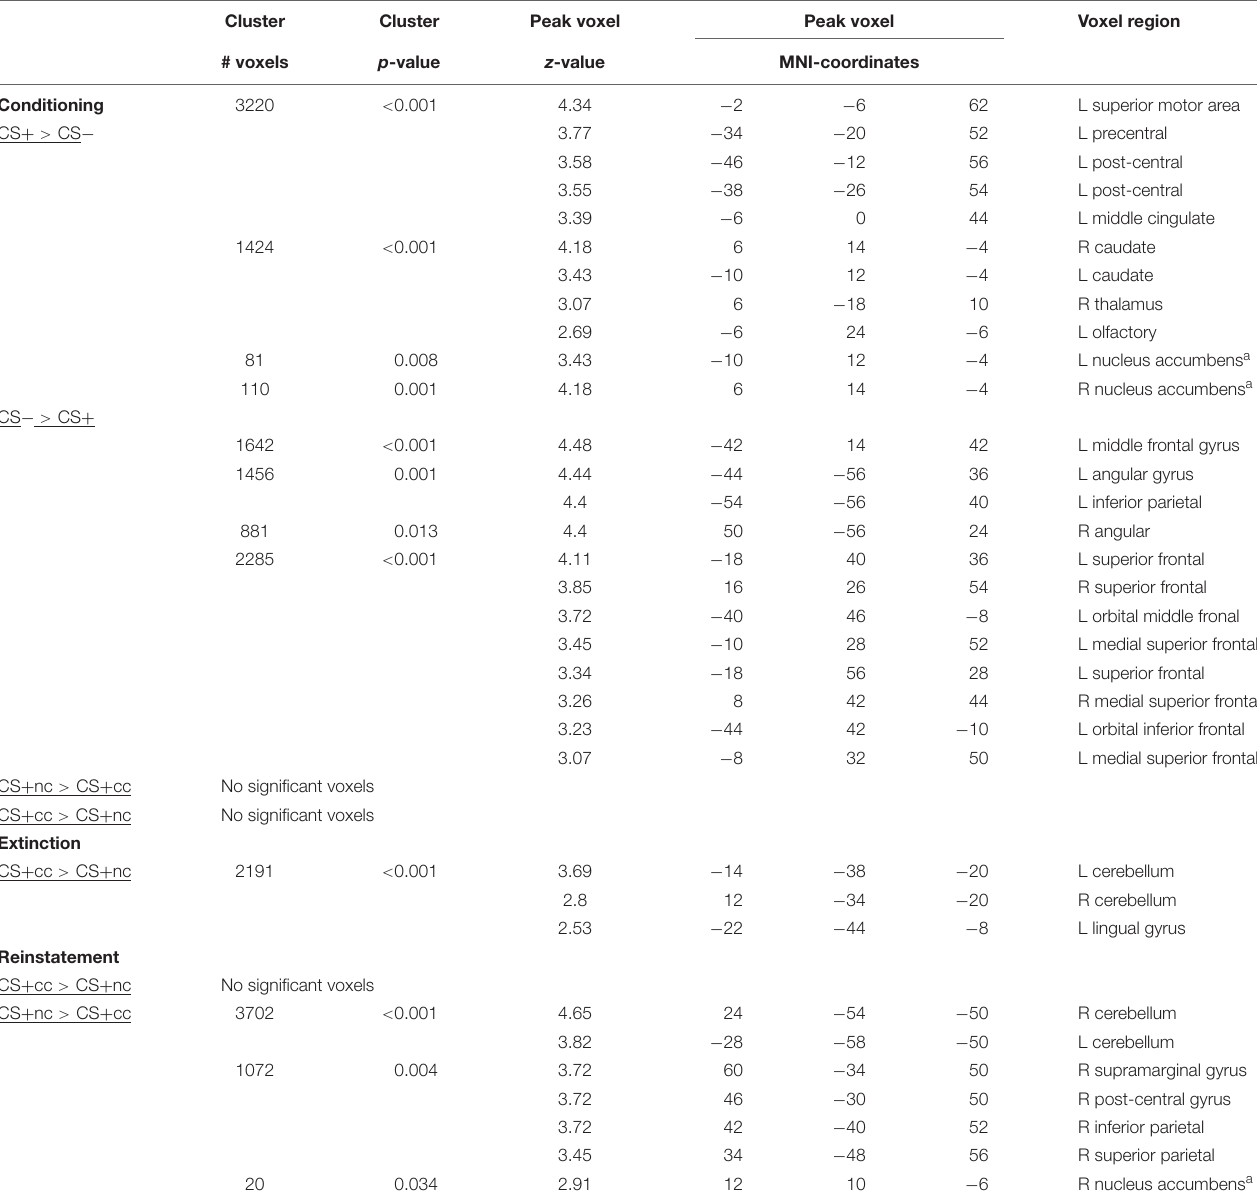
TABLE 1 | Main effects of appetitive conditioning and effect of aversive counterconditioning on reward-reinstatement. Cluster Cluster Peak voxel Peak voxel Voxel region # voxels p -value z